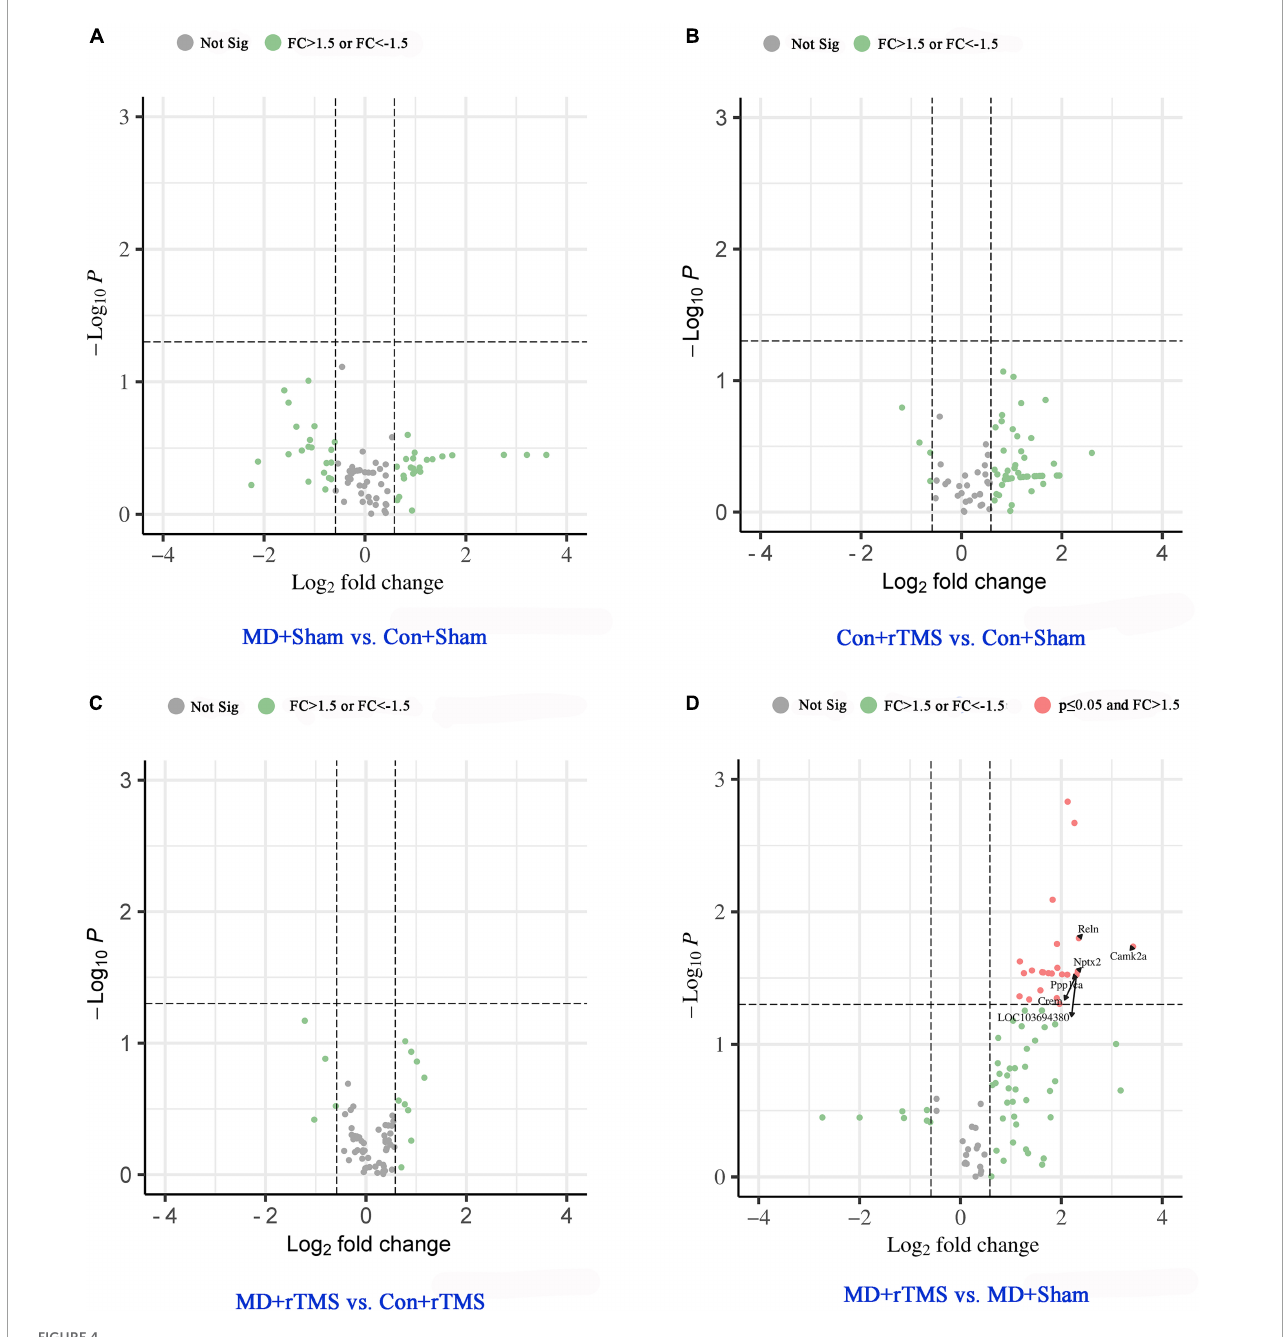
FIGURE4 Volcano plots of gene expression changes based on chosen pairwise group comparison. Genes with > 50% increased or decreased expression with no significance are shown as green-filled dot, while gray-filled dots indicate gene expression changes between − 50 and +50% with no significance. The gene expression changes with p < 0.05 (above y = 1.30) were categorized as significant and labeled as red-filled dots. (A) Gene expression change between MD+Sham and Con+Sham groups. (B) Gene expression change between Con+rTMS and Con+Sham groups. (C) Gene expression change between MD+rTMS and Con+rTMS groups. In the above pairwise comparison groups, no statistically significant difference was observed in the gene expression. (D) Compared to the MD+Sham group, 25 synaptic plasticity genes were significantly upregulated in MD+rTMS group, and no gene was significantly downregulated. The top six increased synaptic plasticity genes are marked with black arrows. Not Sig, not significant; FC, fold change.